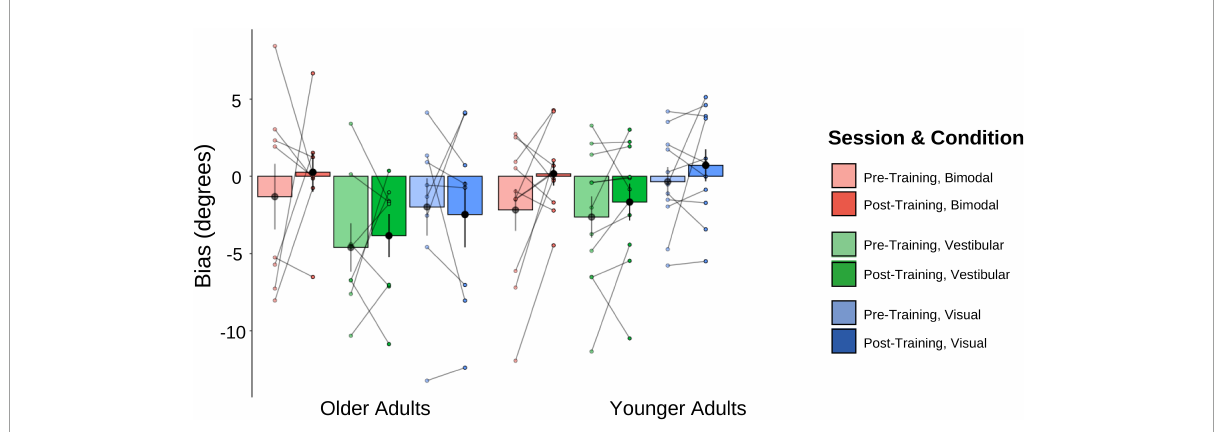
FIGURE7 Biases plotted for each Age Group and sensory condition. Pre-training values (lighter shades) and post-training (darker shades). Individual data points are also plotted, with lines connecting each participant’s pre-training bias to their post-training bias, for each of the three sensory conditions (visual-only, vestibular-only, bimodal). Black dots represent means, plotted with standard error